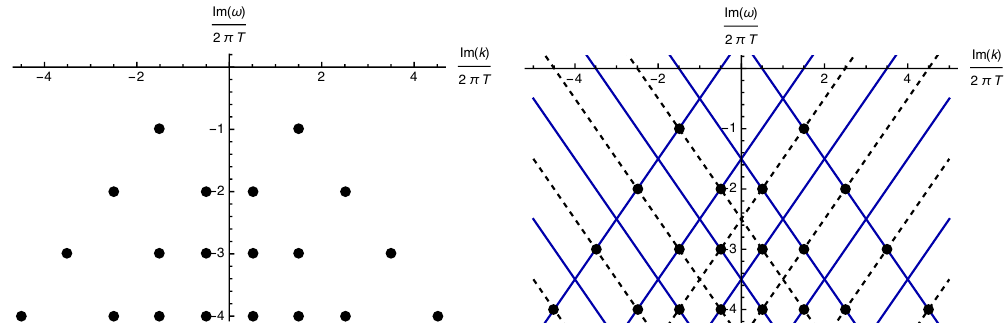
Figure 1 . The left hand plot shows the locations (4.6) where our study of near horizon perturba- tions predicts pole-skipping for a (cid:12)eld in the BTZ background with (cid:1) = 2 : 5 and for n = 1 ; 2 ; 3 ; 4. The right hand plots shows the dispersion relations (4.8) and (4.9) of the lines of poles (dashed) and zeroes (solid) in the (cid:1) = 2 : 5 Green’s function (4.7). These lines can be seen to intersect precisely at the pole-skipping locations (4.6), as expected from our analysis in section